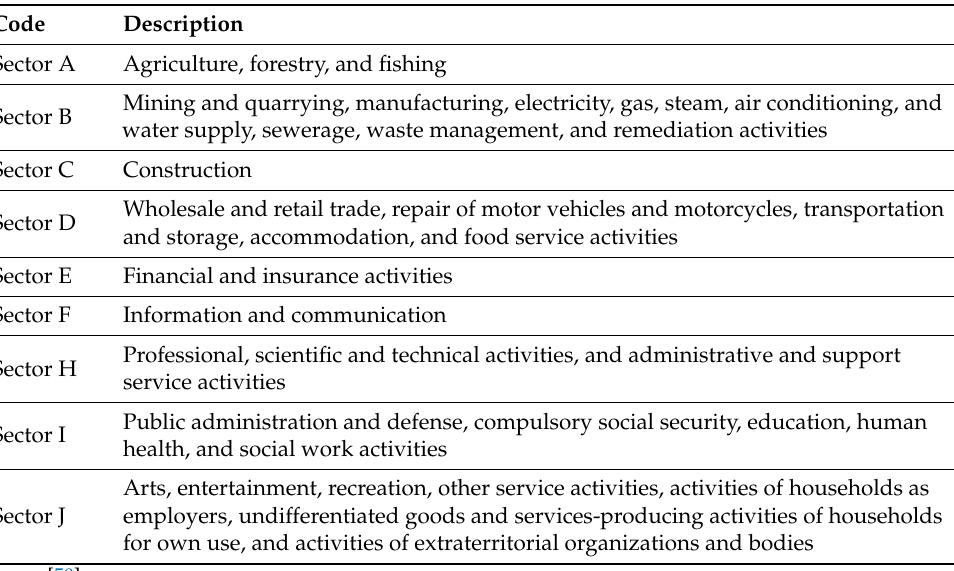
Table 1. The productive sectors that are considered in the